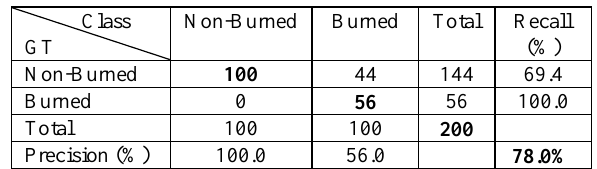
Table 1 . Performance comparison of the global and the local model in Indonesia with predictions based on the Indonesian test dataset.